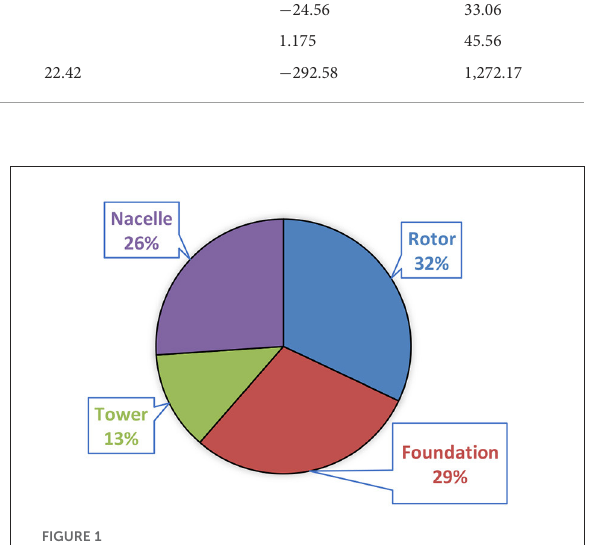
FIGURE1 CED for the main parts of the wind